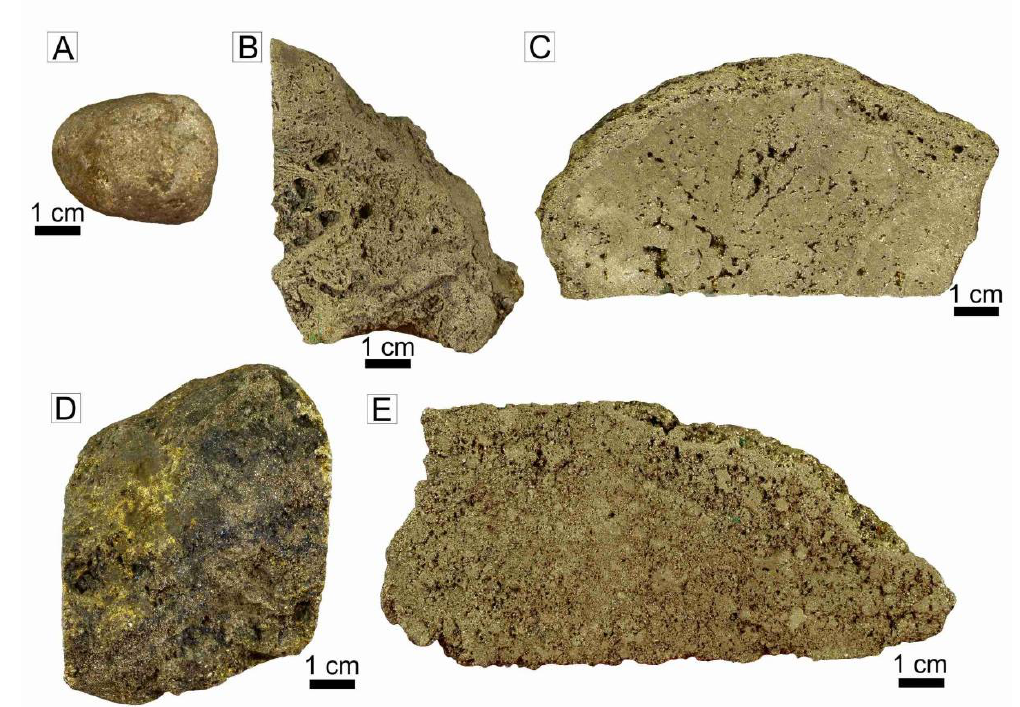
Figure 7. Representative drill core samples from the three eSMS mounds drilled during Blue Mining cruise JC138. ( A ) Sulfide pebble comprising pyrite and chalcopyrite (Southern M., 50-14, 6.63–6.73 mbsf). ( B ) Vuggy massive sulfide comprising marcasite and sphalerite (Rona M., 57-19, 7.09–7.26 mbsf). ( C ) Massive sulfide predominately consisting of pyrite with thin intercalated chalcopyrite layer (Rona M., 65-23, 12.32–12.41 mbsf). ( D ) Massive pyrite with chalcopyrite on a fractured surface (Rona M., 65-2, 9.36–9.59 mbsf). ( F ) Sulfide breccia comprising pyrite hosted in a matrix of chalcopyrite (MIR Zone,